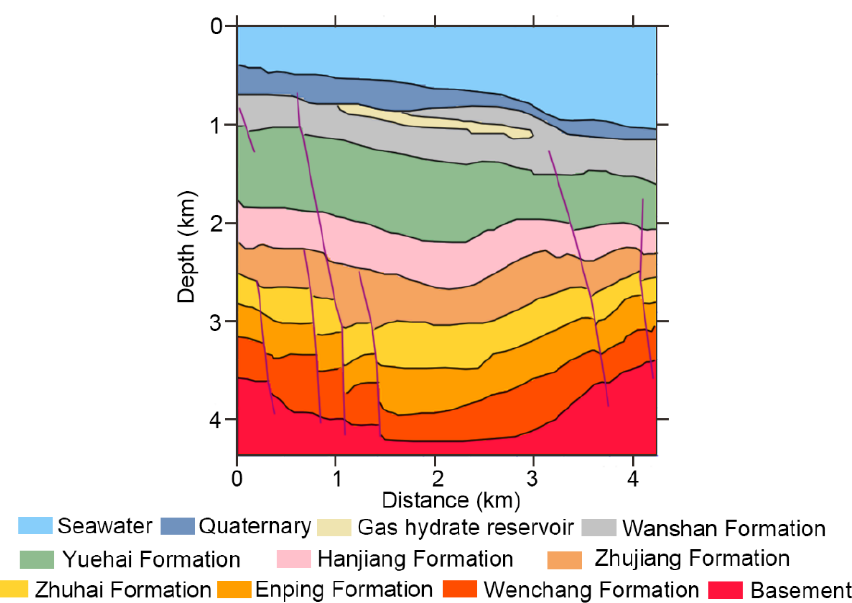
Figure 3. The geological model for synthetic data analysis. The black lines indicate the stratigraphic horizons and the red lines indicate the faults.